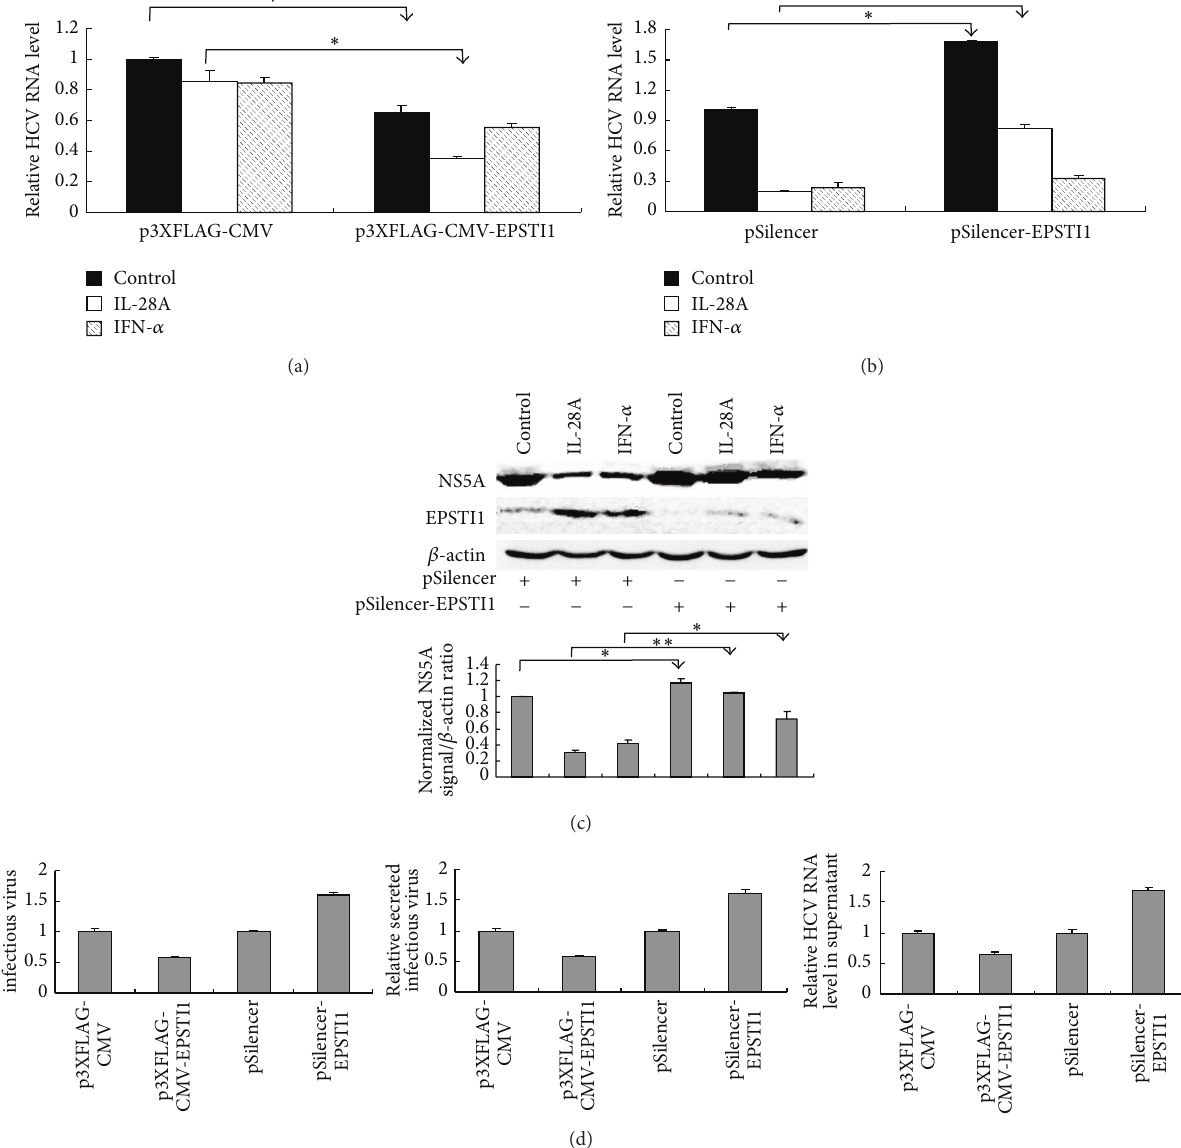
Figure 4: EPSTI1 exhibits anti-HCV activity. (a) Huh7.5 cells were transfected with p3XFLAG-CMV-EPSTI1 or vector followed by HCV infection (MOI = 0.1). The cells were incubated with IL-28A (5ng/mL), IFN- 𝛼 (0.5U/mL) for 48 h, or without treatment as a control. Intracellular HCV RNA was detected with real-time PCR and normalized with GAPDH. (b) EPSTI1 shRNA or control shRNA was delivered into Huh7.5 cells. The cells were infected with HCV (MOI = 0.1) and incubated with IL-28A (20 ng/mL), IFN- 𝛼 (5U/mL) for 48 h, or without treatment as a control. (c) The cells were treated as described in part (b). The proteins of NS5A and EPSTI1 were detected with western bolt. (d) Huh7.5 cells were transfected with p3XFLAG-CMV-EPSTI1/pSilencer-EPSTI1 or vectors followed by HCV infection (MOI = 0.1). The intracellular infectious virus and the secreted infectious virus were detected with FFU assay. HCV RNA in the supernatant was extracted and detected with real-time